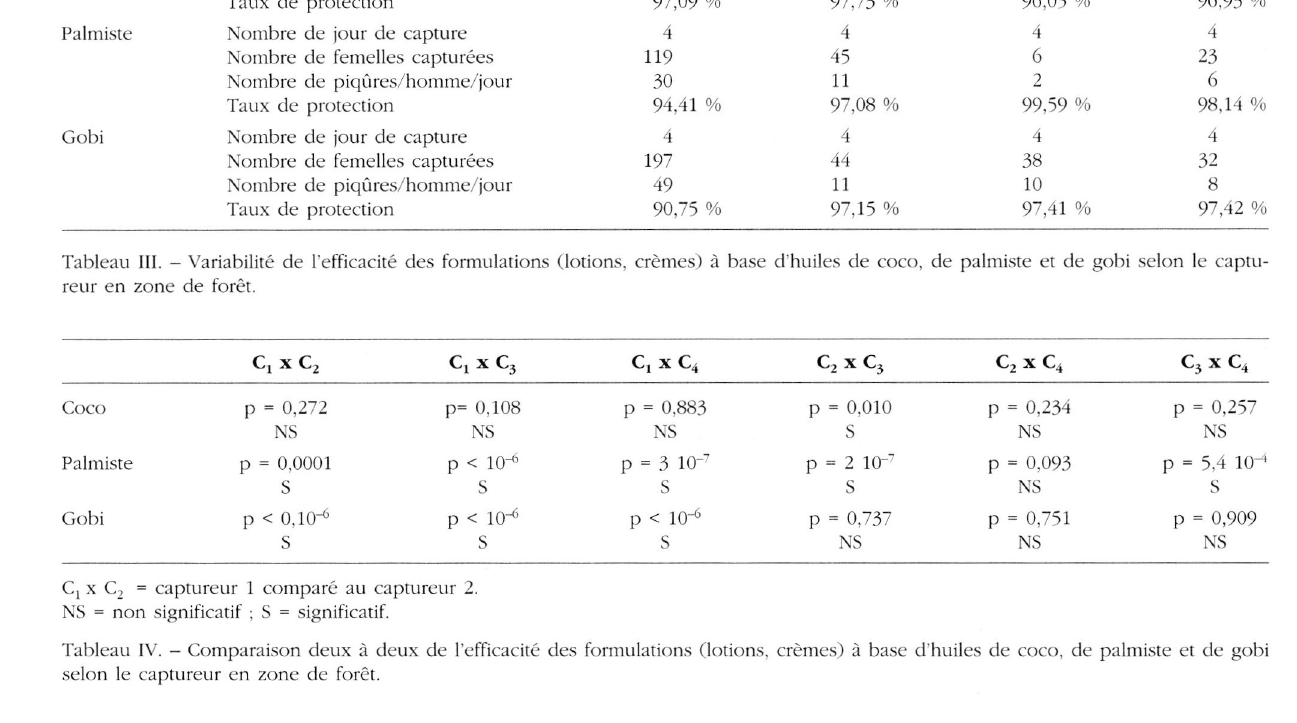
une densité simulidienne maximale de six piqûres par homme et par